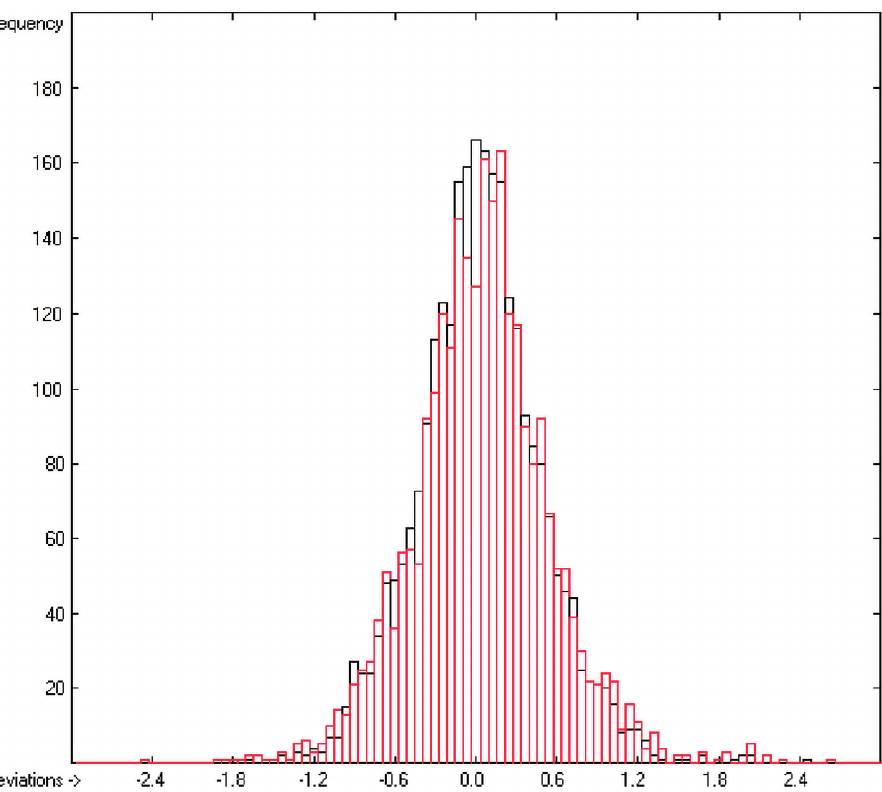
Figure 6. Histogram of logP data (S =